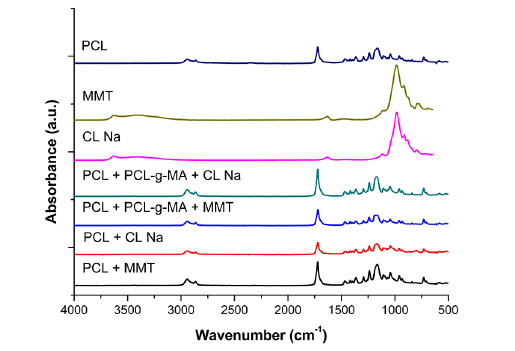
Figure 4. FTIR spectra of MMT and CLNa clays and PCL